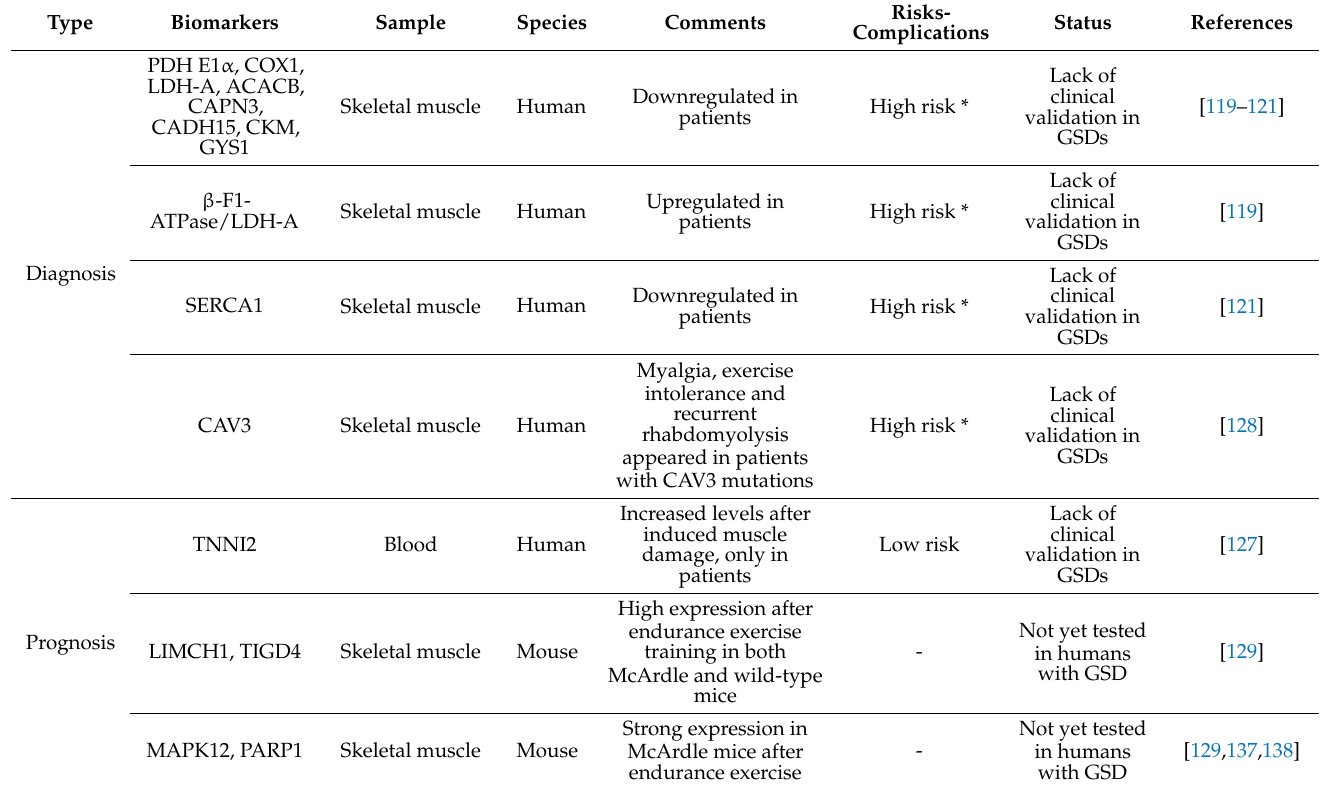
Table 4. Experimental biomarkers in